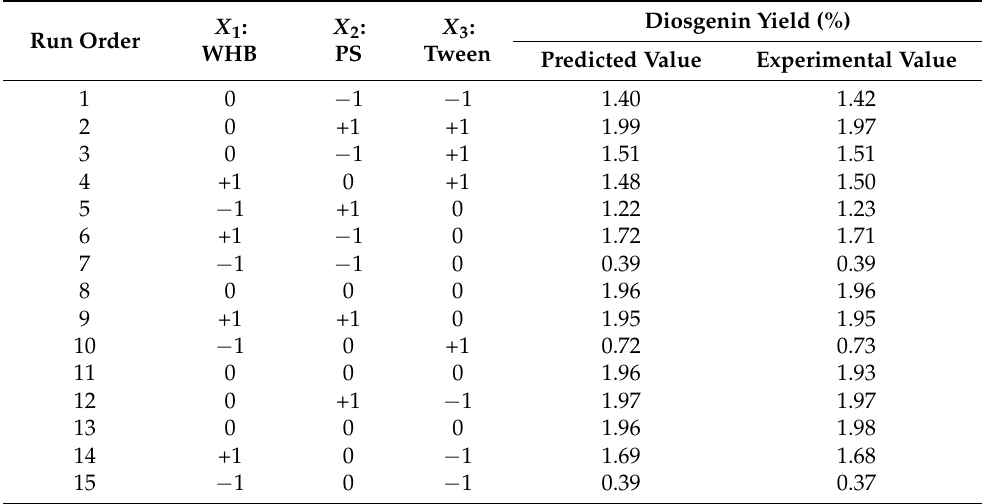
Table 3. Diosgenin yield under various SmF conditions in Box–Behnken design (BBD) matrices.